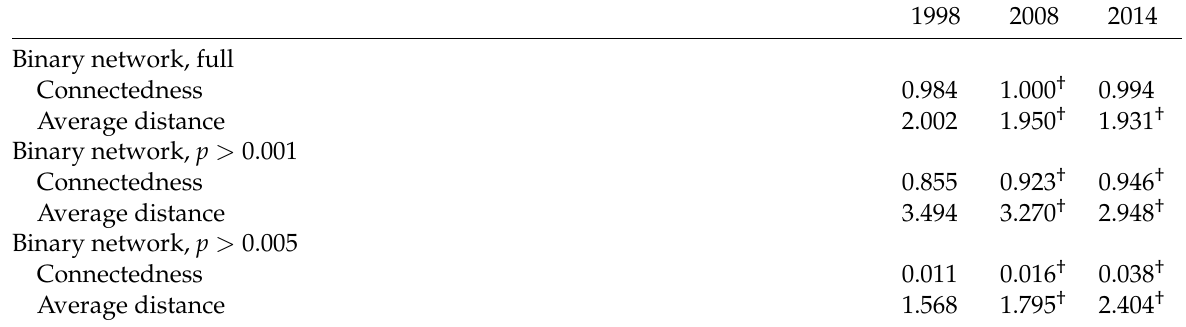
Table 2: Network connectedness and average geodesic distance for all men, 1998 to